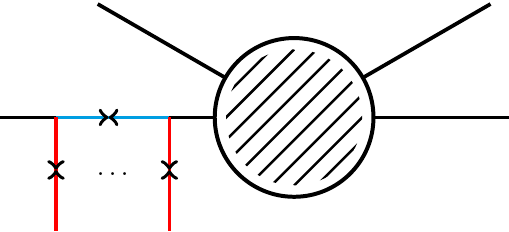
Figure 9 . Feynman diagram for multiple soft gravitini | III.